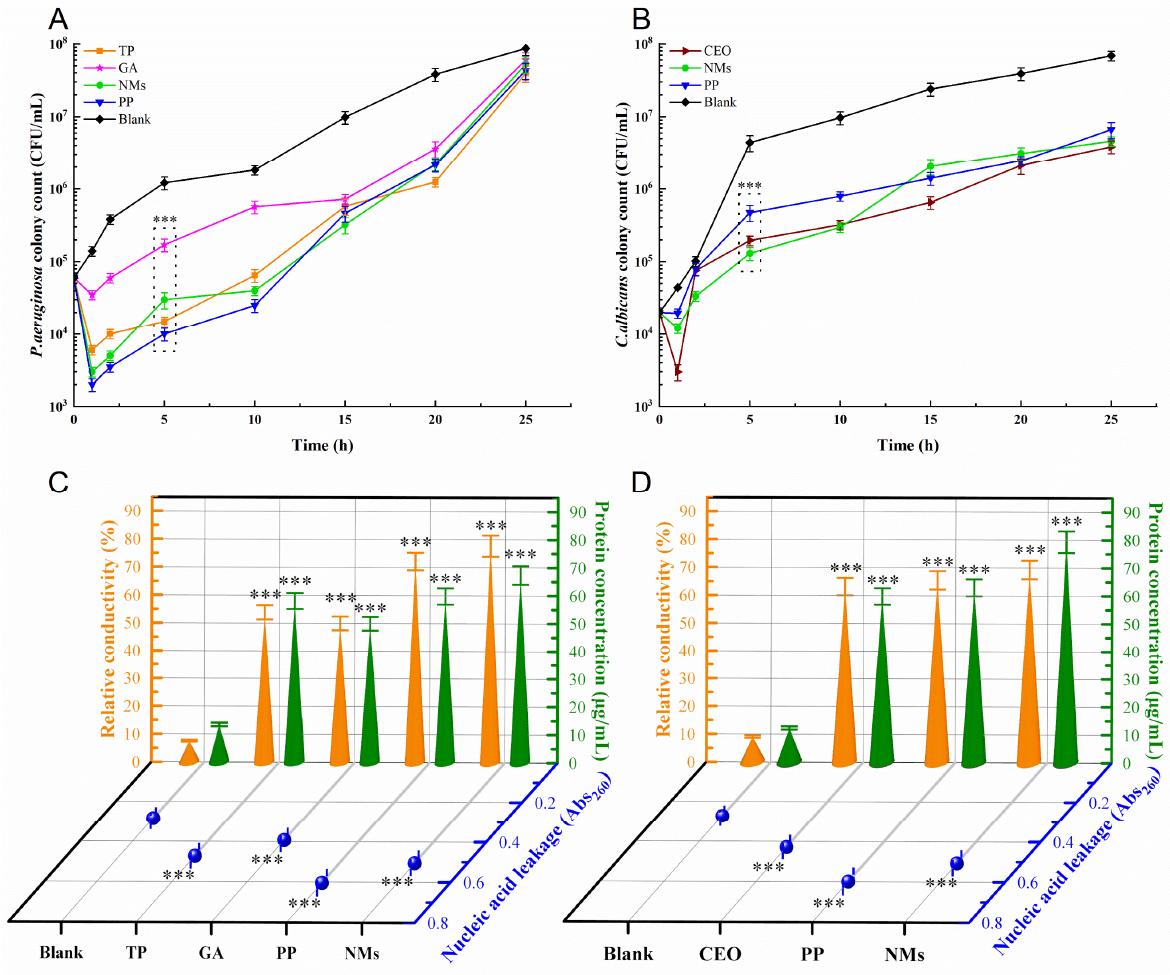
Figure 5. Bacteriostatic mechanism data of NMs. ( A ) Growth curve of P. aeruginosa , ( B ) growth curve of C. albicans , ( C ) cell membrane permeability of P. aeruginosa , ( D ) cell membrane permeability of C. albicans . PP was selected as a positive control, and no bacteriostatic agent was selected as a blank control. Each value represents means ± SD ( n = 3). *** indicates statistical difference at p < 0.001 level compared with blank